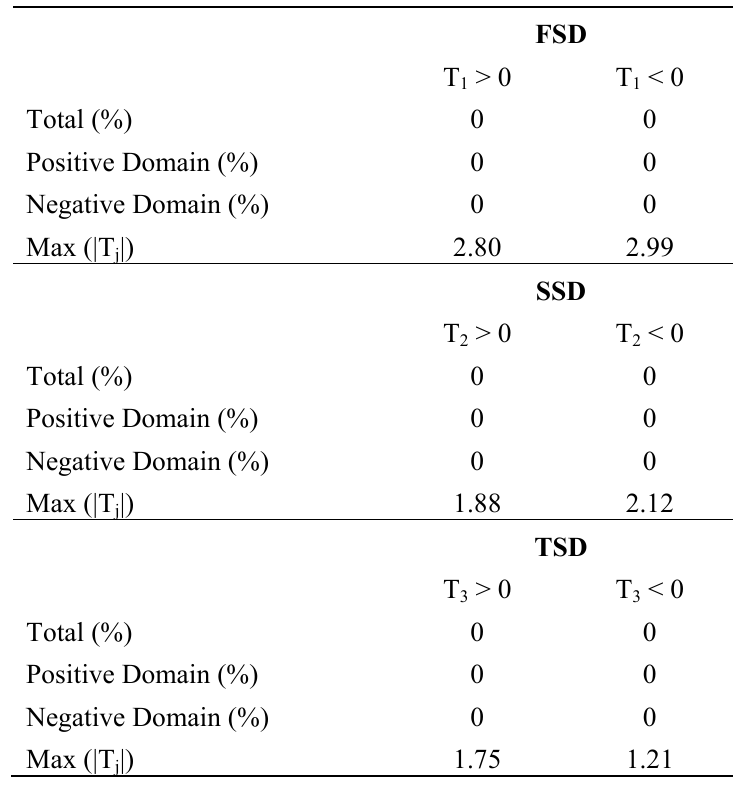
Table 7. The results of the stochastic dominance (SD) statistics for the first domestic diversified portfolio (DOD1) and the fifth international diversified portfolios